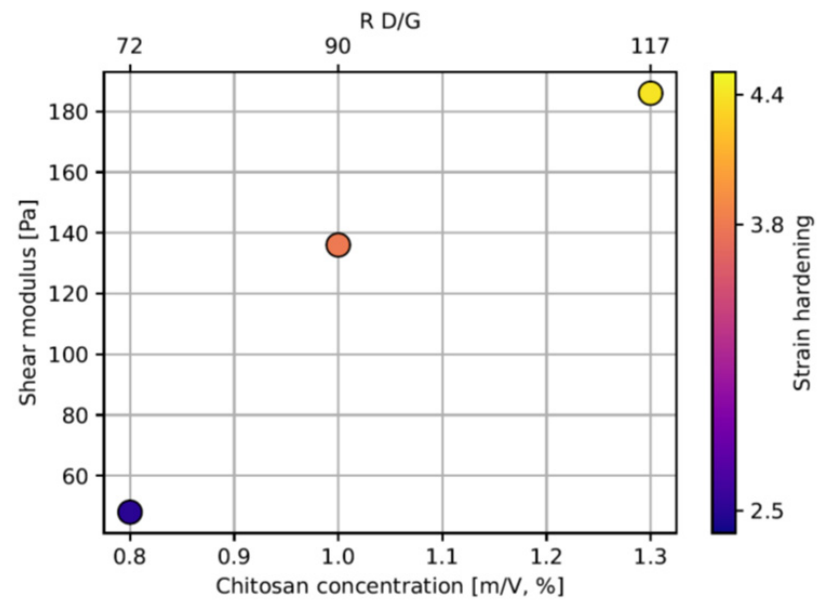
Figure 2. Dependence of the shear modulus from chitosan concentration for genipin-based hydrogels. The color bar on the right-end side represents the strain hardening of the hydrogels, defined as G (cid:48) max / G (cid:48) 0 (see Equation (4)). The amount of genipin used for all hydrogels was 0.31 mM. The value of R D/G associated with each hydrogel is reported on the upper x -axis. Chitosan concentration is varied in the range from 0.8% to 1.3%.